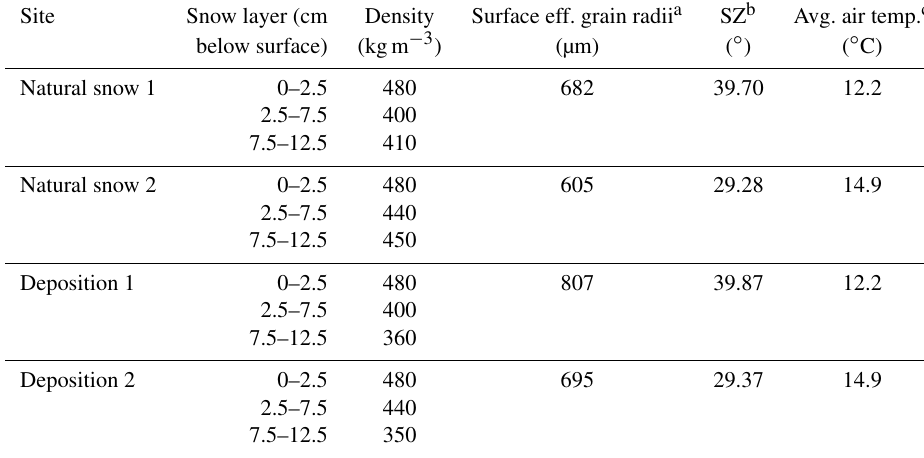
Table 1. Snowpack observations and spectral albedo properties. Site